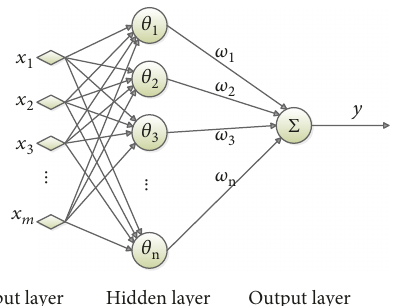
Figure 1: Structure of a MISO RBF NN.